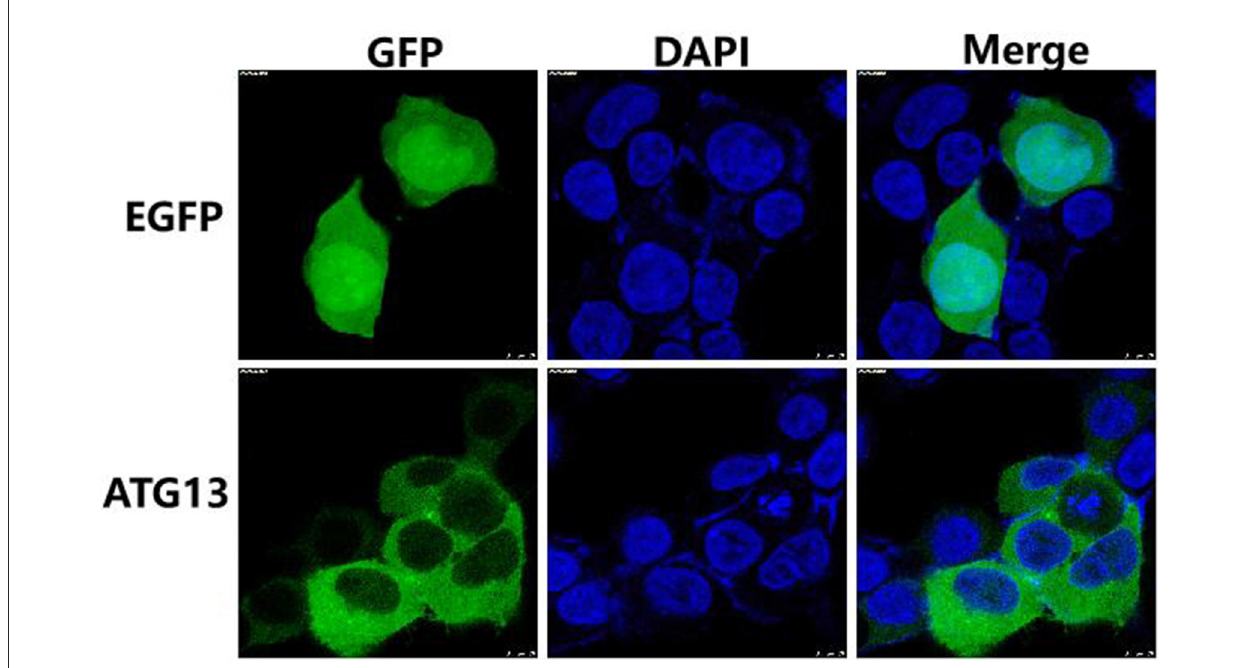
FIGURE5 Subcellular localization of TgATG13 in HEK293T cells. HEK293T cells were transfected with pcDNA3.1-EGFP or pcDNA3.1-EGFP-TgATG13 for 24h. DAPI was used to stain cell nuclei. Scale bar = 7.5 µ m.